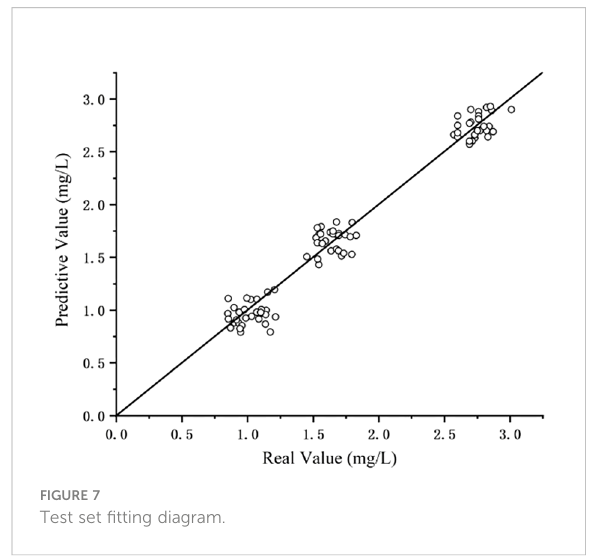
FIGURE 7 Test set fi tting diagram.